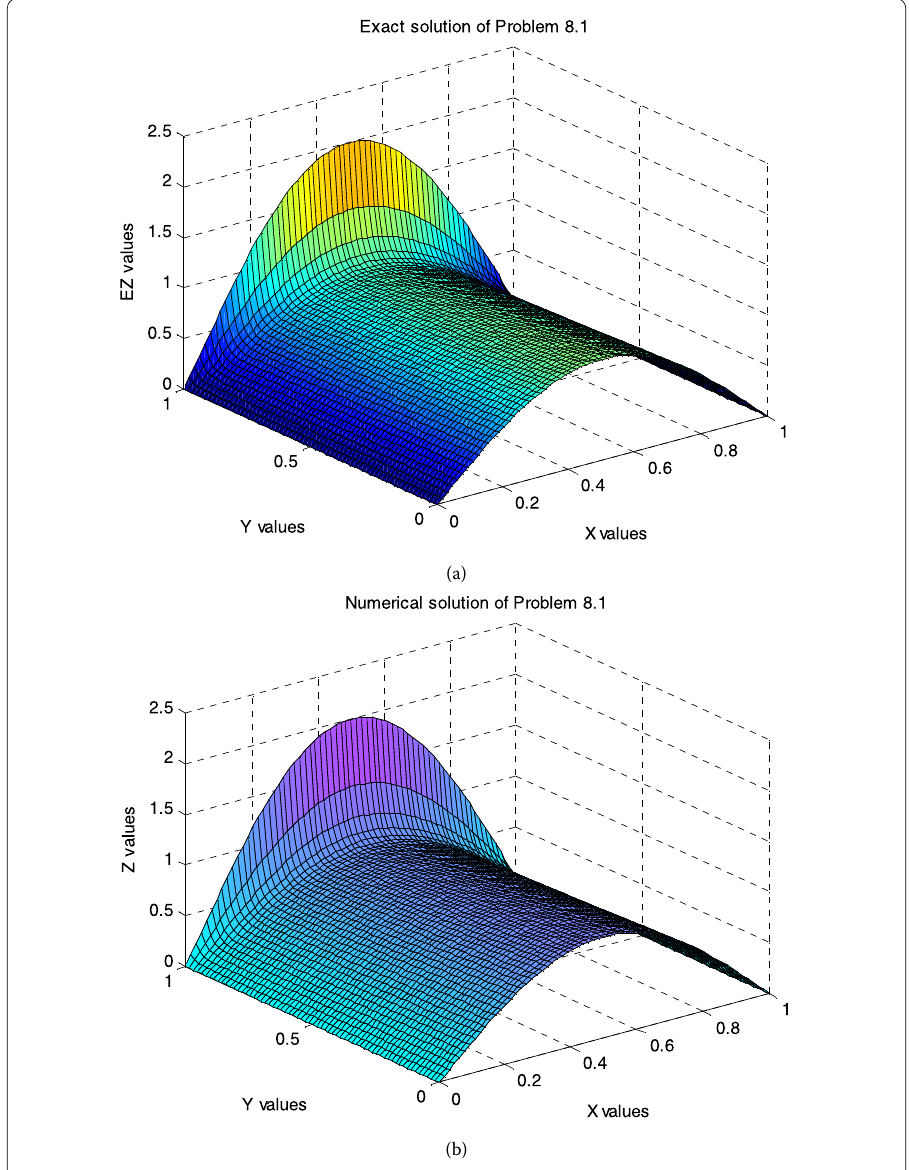
Figure 2 ( a ) Exact solution of Problem 8.1 for h = 1/64 and β = 50. ( b ) Numerical solution of Problem 8.1 for h = 1/64 and β = 50